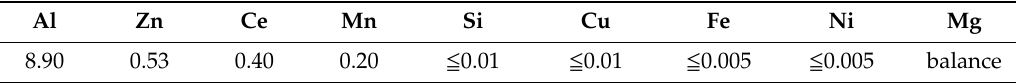
Table 1. Chemical composition of AZ80 + 0.4%Ce magnesium alloy (wt %).